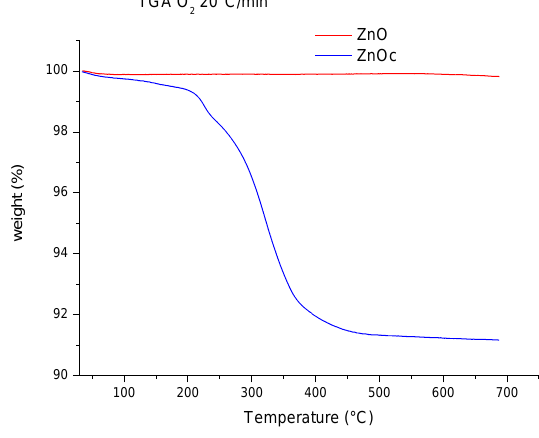
Figure 1. Thermostability curve of ZnO and ZnOc particles.